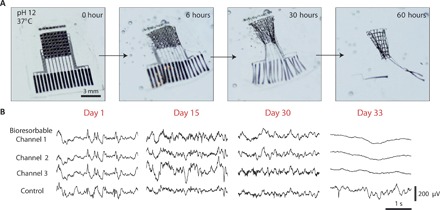
Transient, bioresorbable electronics.(A) Transient bioelectronic ECoG array micrographs of active ECoG array with Si transistors under accelerated (high pH) testing conditions. (B) Recording from three channels and a control (nonbioresorbable channel) over 33 days in vivo. The transient array is fully functional for >30 days in vivo. Reproduced with permission from Yu et al. (72).